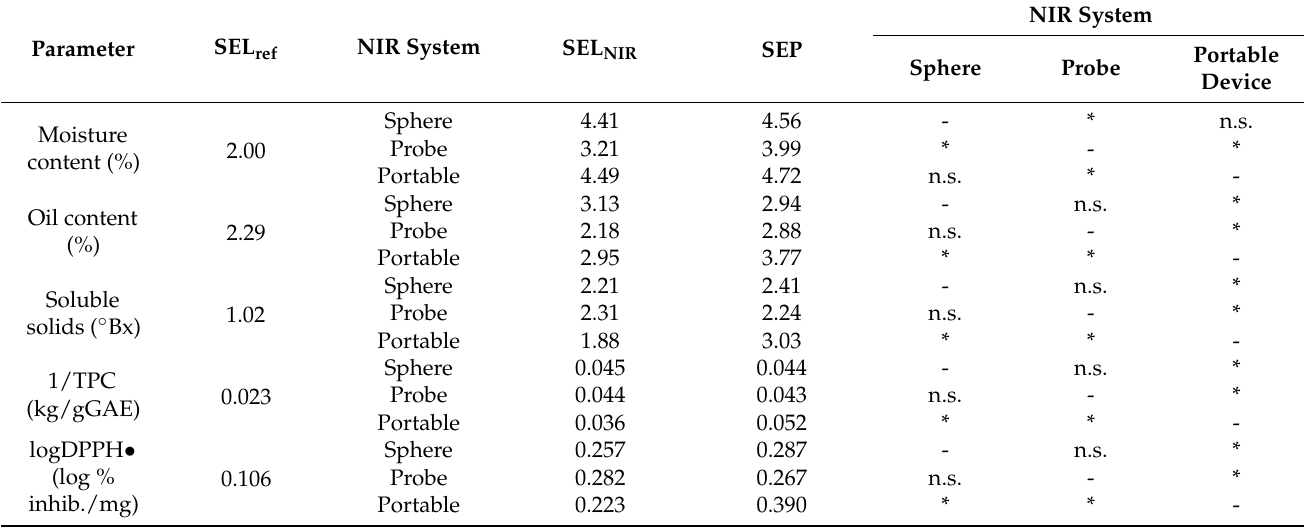
Table 2. Comparison of regression models calculated for olive chemical parameter prediction based on three different FT-NIR and Vis-NIR acquisition systems.